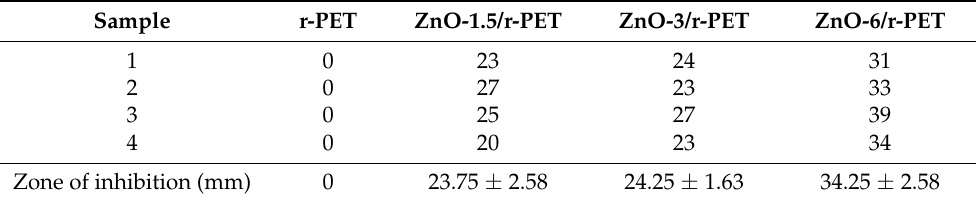
Table 3. Average diameters in millimeters of the inhibition haloes of Bacillus subtilis bacteria at different concentrations of ZnO-NPs.